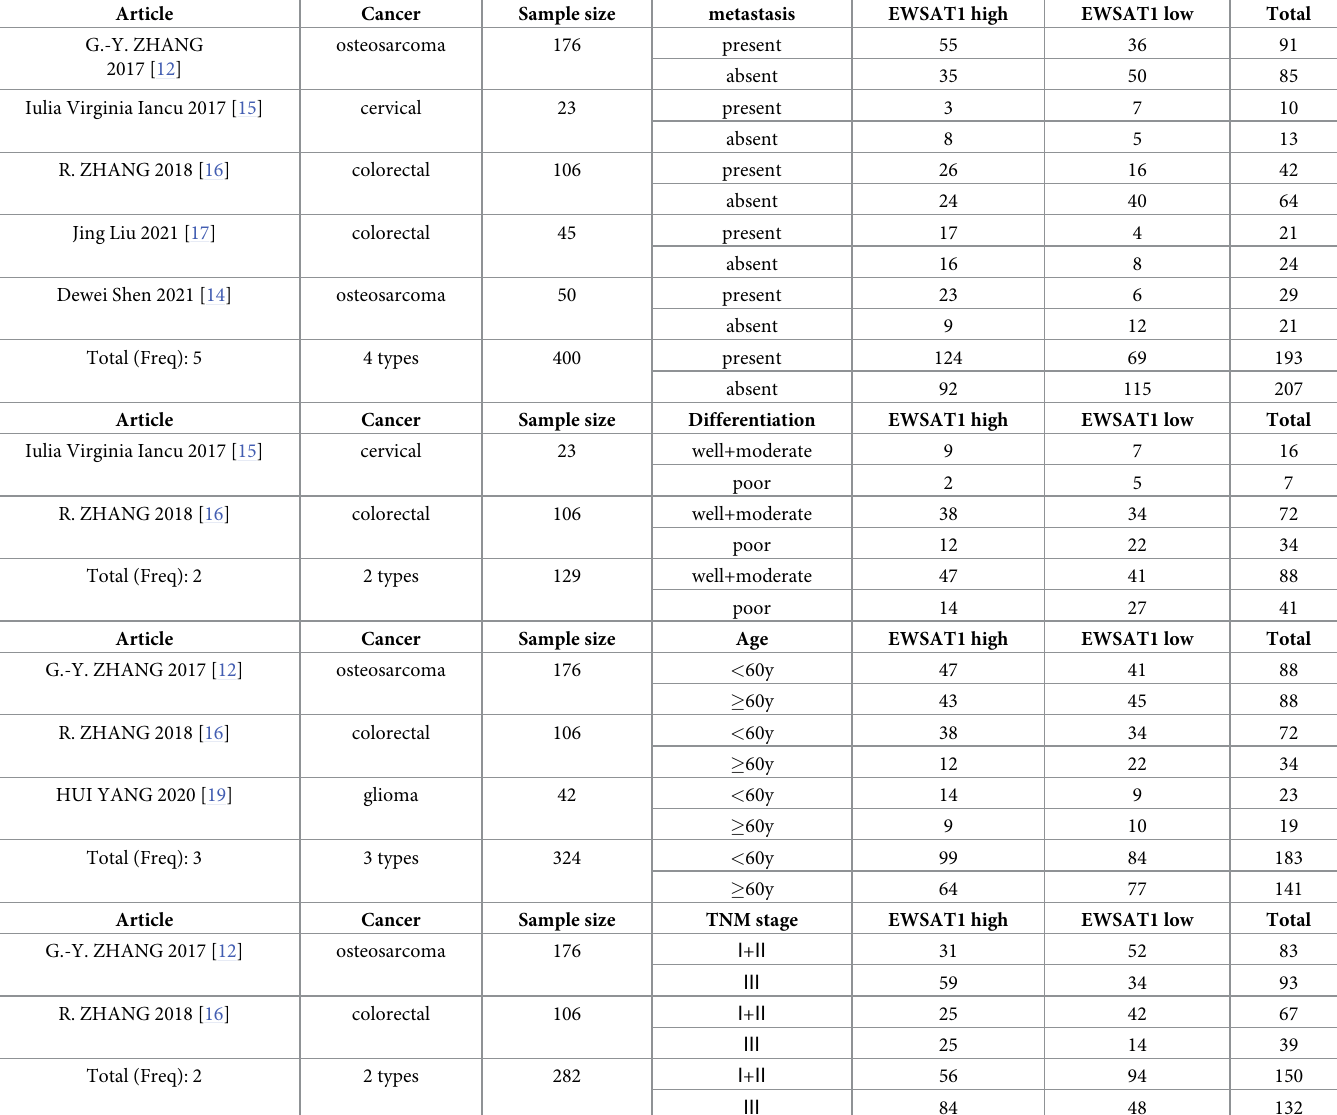
Table 2. Distribution characteristics of EWSAT1 in the patients with different clinicopathological